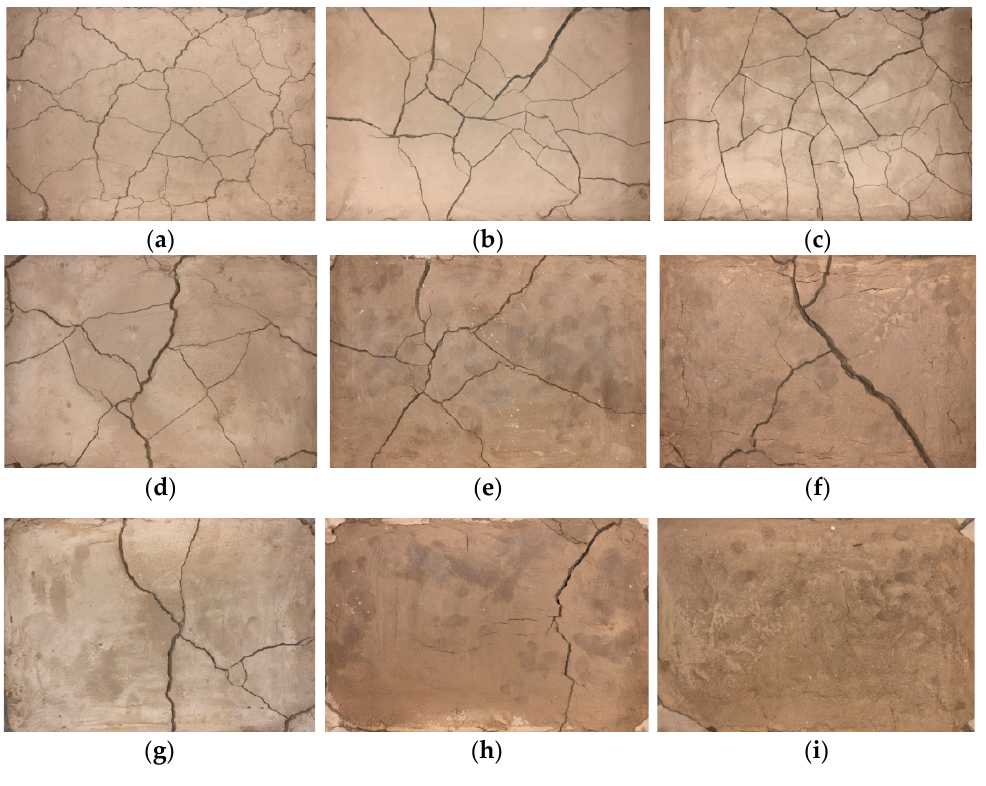
Figure 7. Pictures of dry shrinkage test results. ( a ) A 1 B 1; ( b ) A 1 B 2; ( c ) A 1 B 3; ( d ) A 2 B 1; ( e ) A 2 B 2; ( f ) A 2 B 3; Table 3. Dry shrinkage test results.